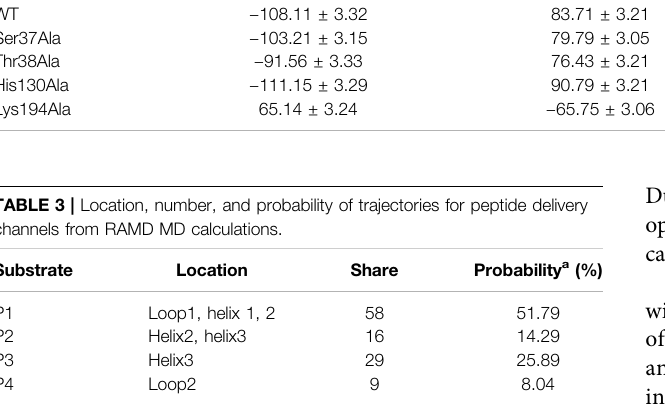
TABLE 2 | Mean values and standard deviations (M ± SD) of binding free energy of wild type enzyme and four mutant systems (kcal/mol). System